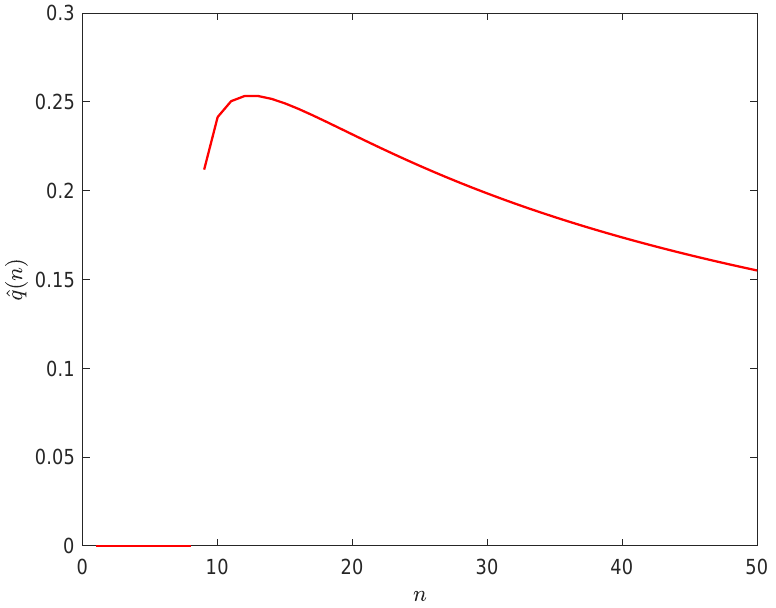
Figure 5. Information Acquisition in Equilibrium When Λ (cid:54) =